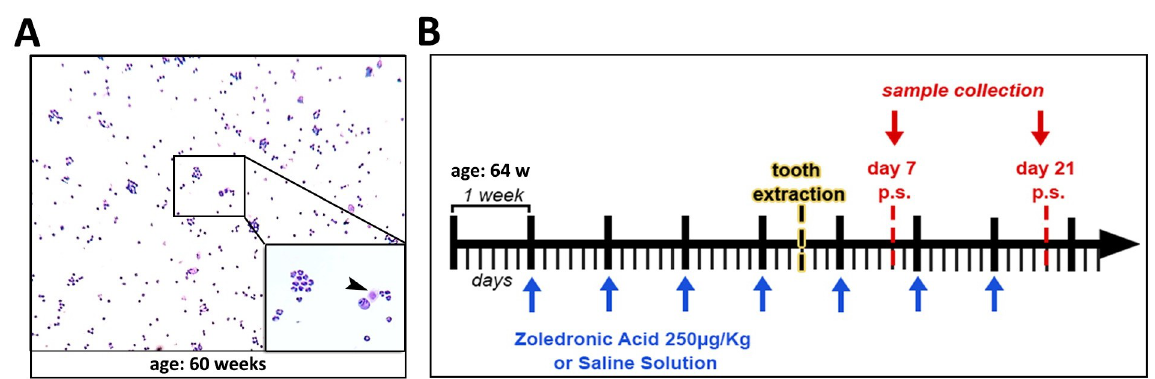
Fig 1. Experimental design of MRONJ model in senescent female 129 Sv mice. A) Vaginal smears with Toluidine blue O stain showing predominance of leucocytes and few nucleated epithelial cells (arrow head) for 4 consecutive weeks, as indicated for 60 weeks of age. B) Schematic timeline for control and ZA groups: mice were treated with 0.9% saline solution or ZA at a dosage of 250 μ g/Kg, starting 4 weeks before tooth extraction.